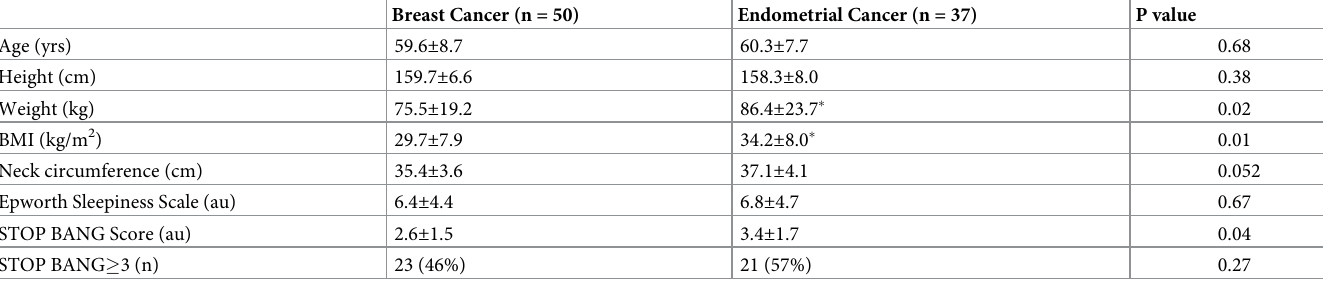
Table 1. Anthropometric data, ESS and STOP-BANG questionnaire scores for breast and endometrial cancer